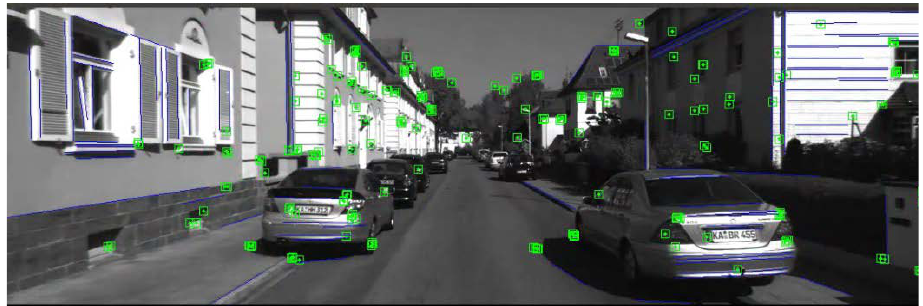
Figure 1. The results of point and line features on the KITTI dataset sequence 00. The green boxes represent the point features extracted from the image, and the blue lines are the extracted line features.